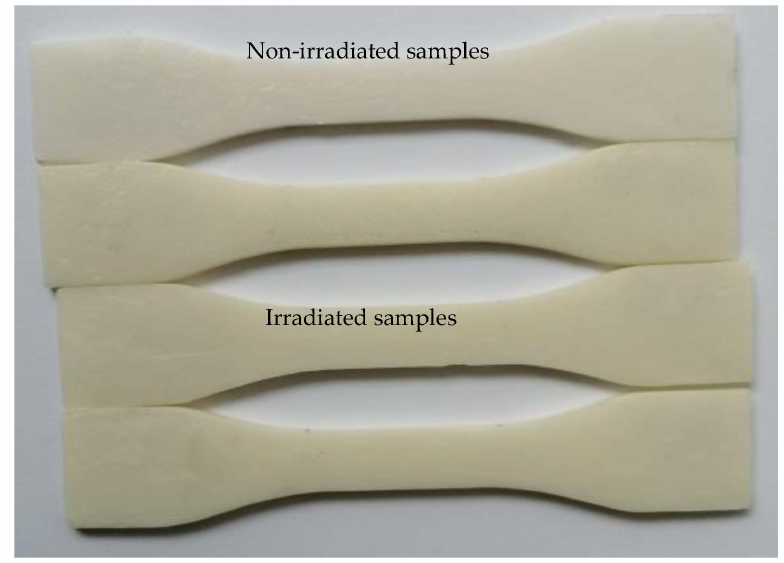
Figure 8. Light yellowing of the PCL samples after 9 h of UV-B irradiation in comparison to a white, non-irradiated sample.